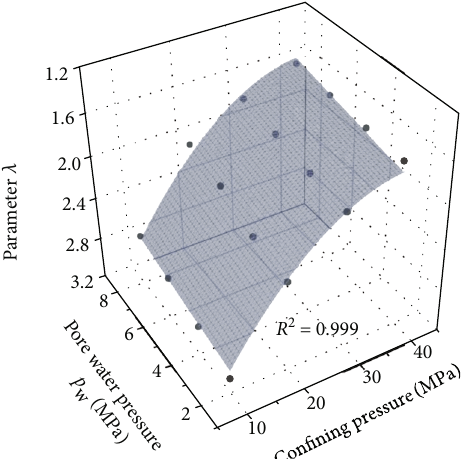
Figure 3: Fitting results of parameters under di ff erent water and force